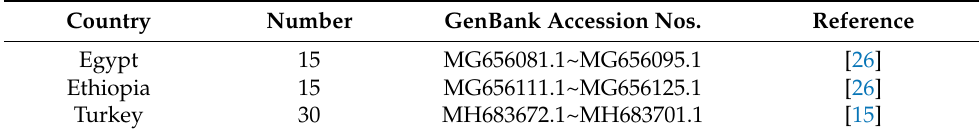
Table 5. GenBank accession numbers of the 60 donkey mtDNA D-loop sequences used in the present study.